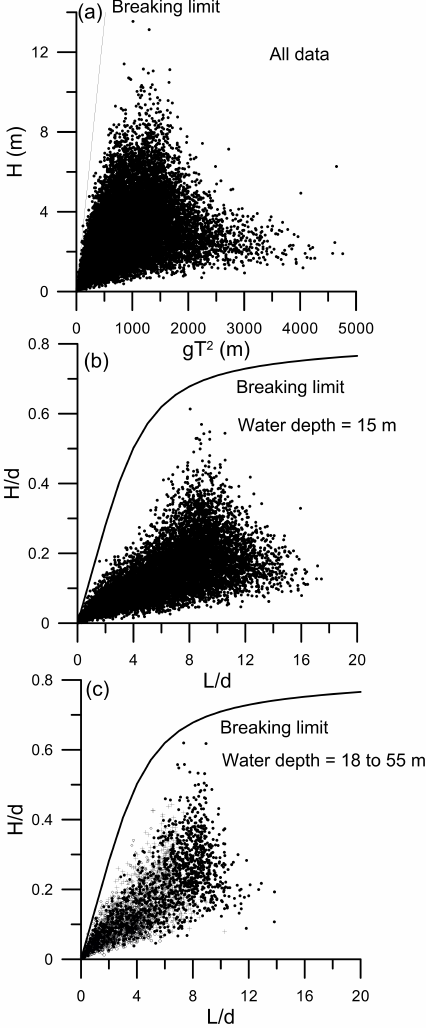
Figure 11. The graph showing the breaking limit based on (a) Ochi (1990) for all data, (b) Fenton (1990) for data at 15m water depth and (c) Fenton (1990) for data at 18 to 55m water depth.